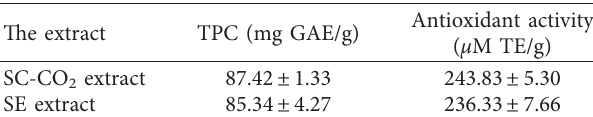
Table 1: Comparison of the TPC and antioxidant activity of the extracts obtained by the SC-CO 2 and SE